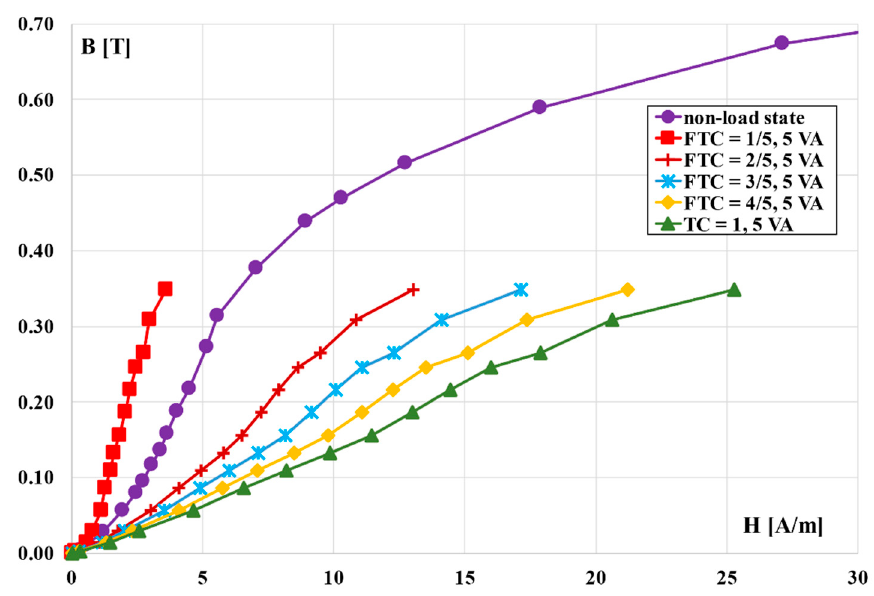
Figure 7. Equivalent magnetization curves of the TCT determined for factional correction of the secondary winding and its rated load (abbreviations: TC—single turn correction, FTC—fractional turn correction).